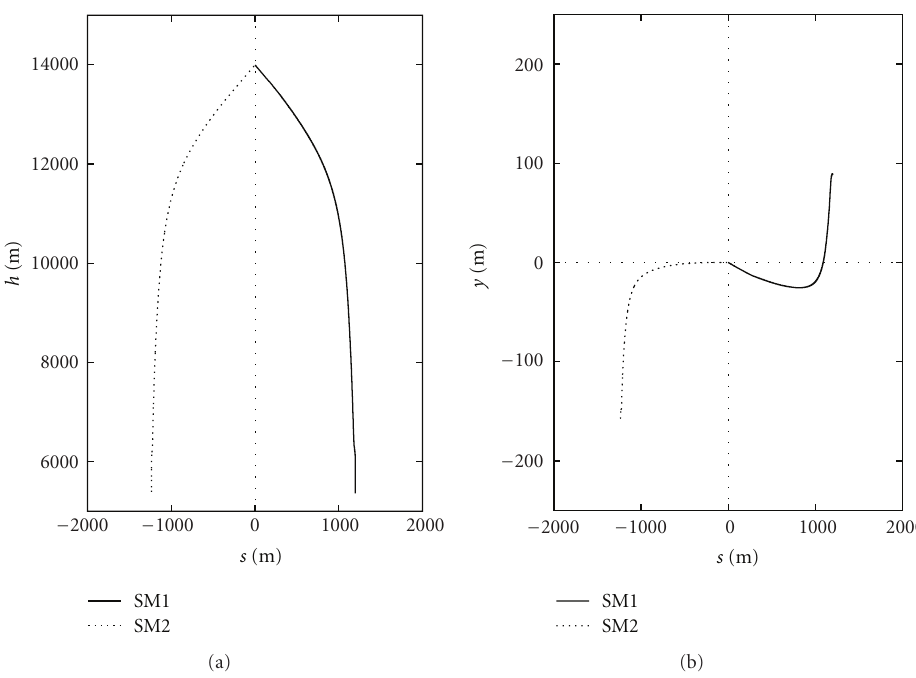
Figure 7: The simulation of the trajectory profile for the parachute-payload system.